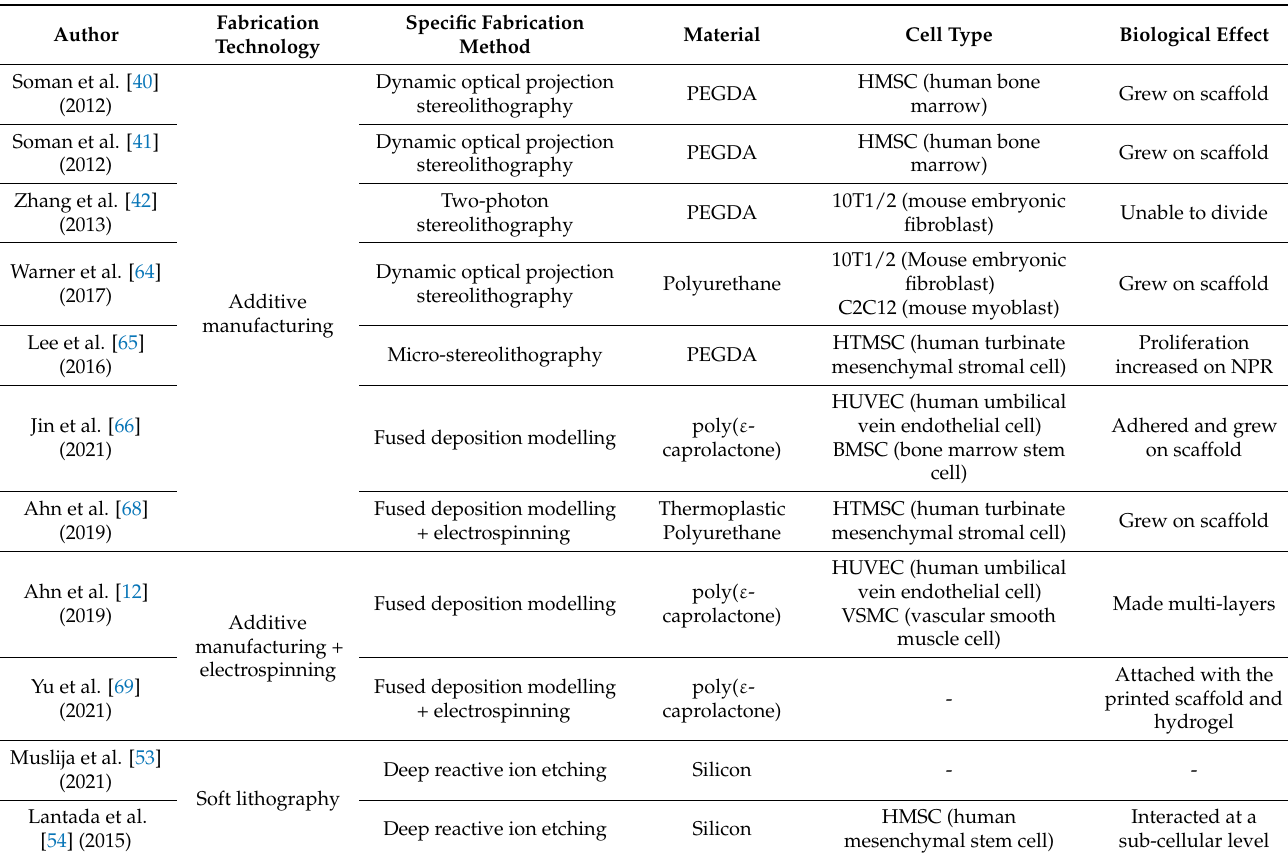
Table 1. Utilization Results of the Auxetic Structure as a Tissue Engineering